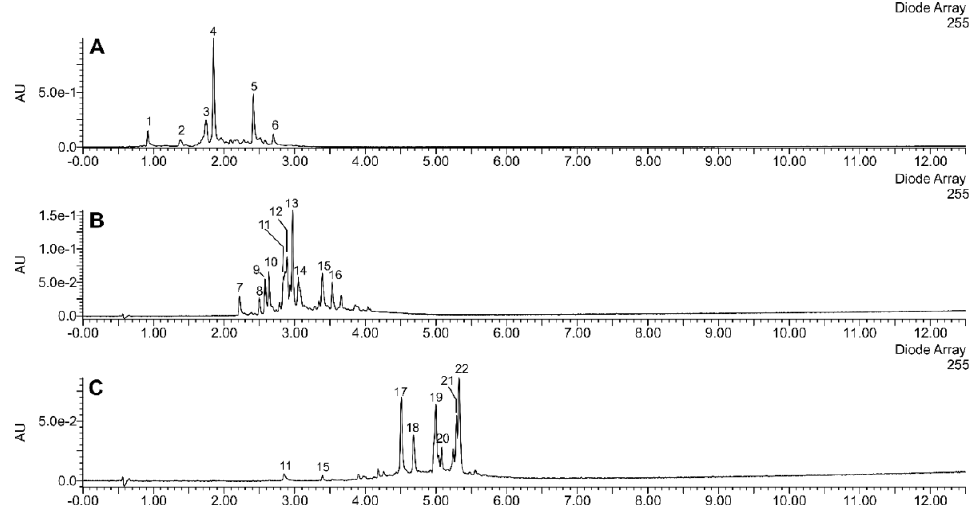
Figure 1. UHPLC-UV chromatogram of preparations ( A – C ), made from the extract of sea buckthorn leaves. Major peaks: